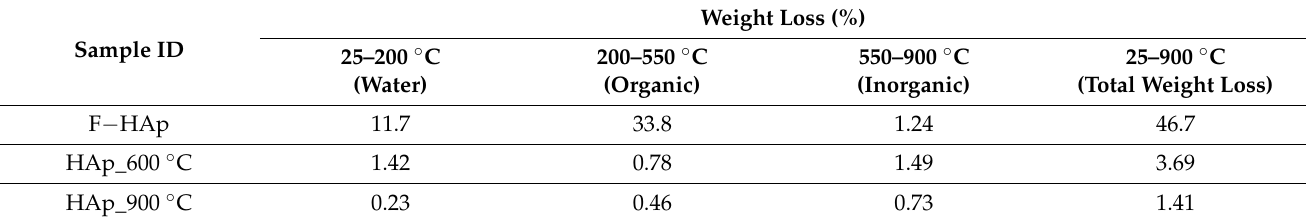
Table 5. Weight loss of each reported thermal event (thermogravimetric